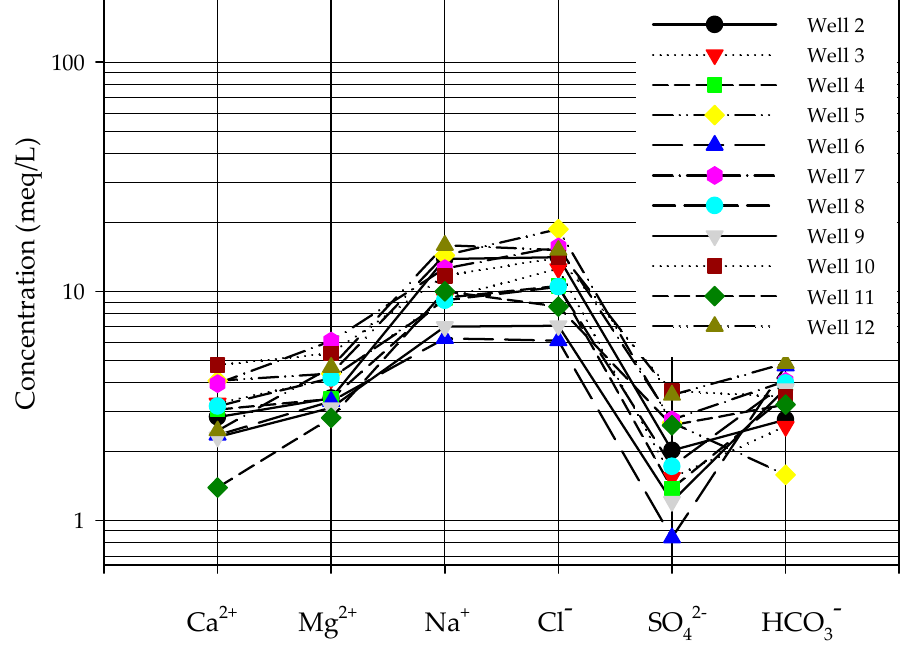
Figure 10. Schoeller diagram corresponding to Type II wells.